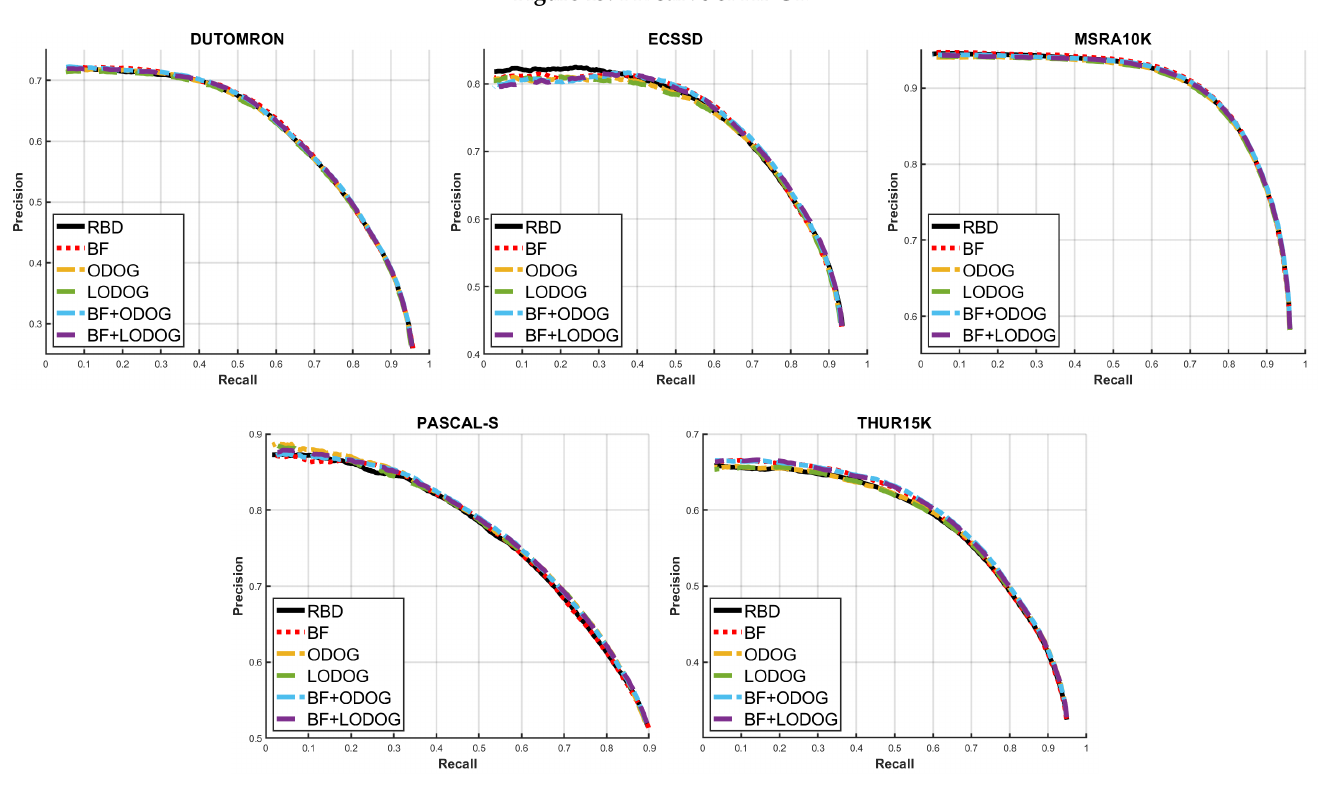
Figure 14. PR curve of